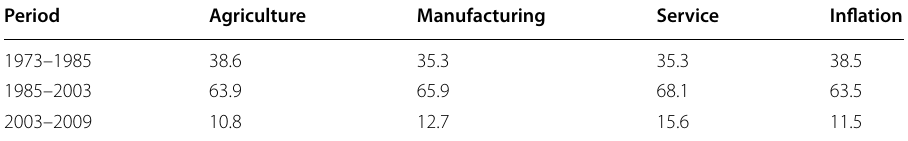
Table 11 Wage growth in sectors and inflation in Turkey (annual rate, unit: %). Source : Author’s calculation. Wage growth was calculated by deriving data from TurkStat and WIOD input–output tables (compensation of employees) Period